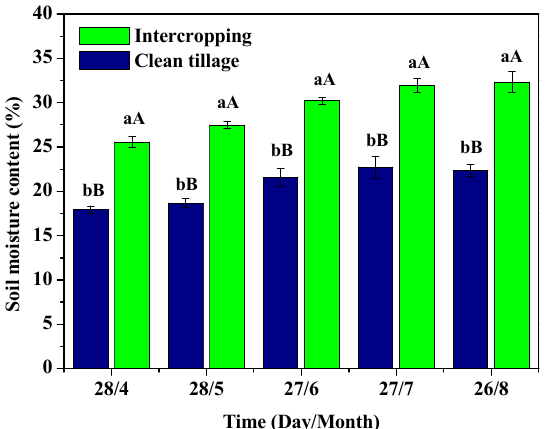
Figure 1. Effects of intercropping V . sativa on the moisture content of soils in young kiwifruit orchard. Values and error bars indicate the mean and SD of three replicates, respectively. Different small and capital letters in the same period indicate significant differences at 5% level ( p < 0.05) and 1% level ( p < 0.01) between intercropping and clean tillage, respectively.